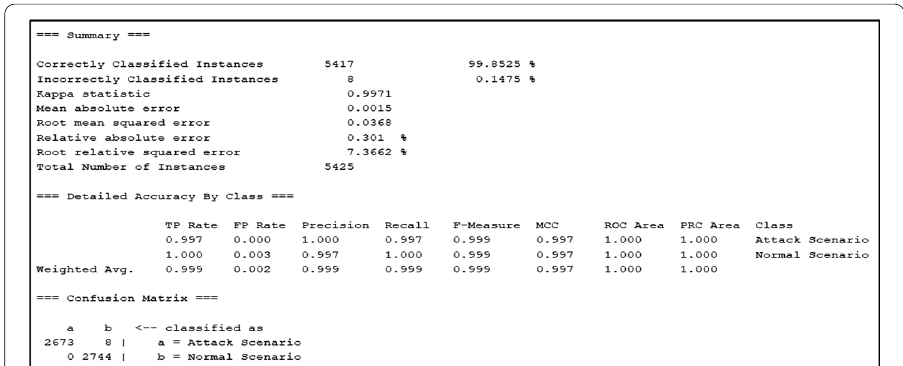
Fig. 4 Detailed Accuracy for Test Dataset using Logistic Machine Learning Algorithm